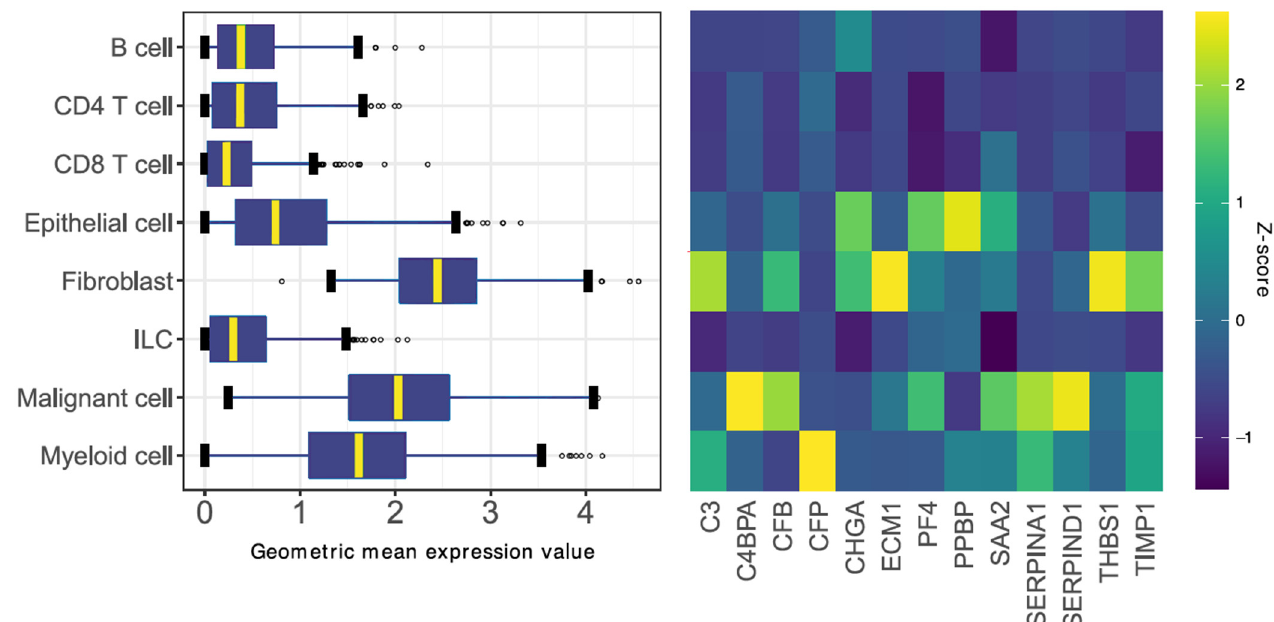
Figure 4. Identification of the stromal and epithelial signatures. (Left Panel) Boxplot summary of 8 major cell populations expressing the 13 stroma-derived genes in colorectal tumors. The boxplots visualize the geometric mean expression value of the pooled 13 genes per cell. (Right Panel) Heatmap of relative gene expression standardized per gene. Genes associated with high (relative) expression in stromal-phenotypic cells (i.e. fibroblasts and myeloid cells) were included in the stromal signature. Genes associated with high expression in epithelial-phenotypic cells (i.e. epithelial and malignant cells) were included in the epithelial signature. ILC, innate lymphoid cell.